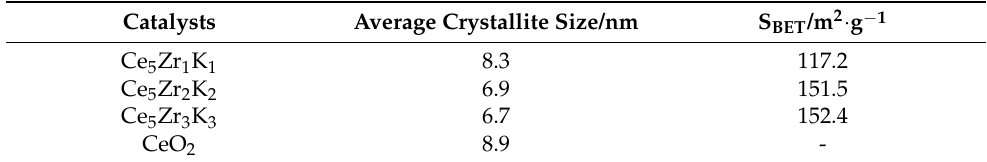
Table 1. Average crystallite size and specific surface area of the CeZrK/rGO catalysts. Catalysts